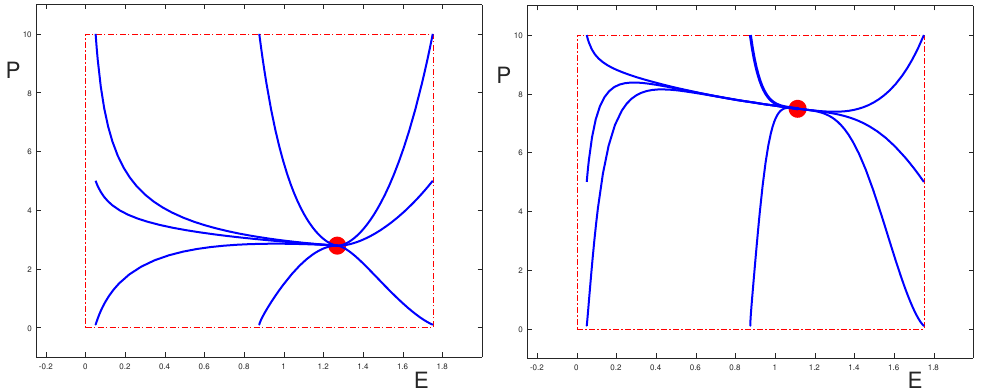
Figure 2. Phase portraits of the reduced dynamics for Q = 0 and P max,1 < P max,2 for the uncontrolled system ( top , left ) and for constant controls u 1 ≡ 1 ( top , right ), u 2 ≡ 1 ( bottom , left ) and u 3 ≡ 1 ( bottom , right ). The numerical values for these phase portraits are given in Tables 1 and 2.